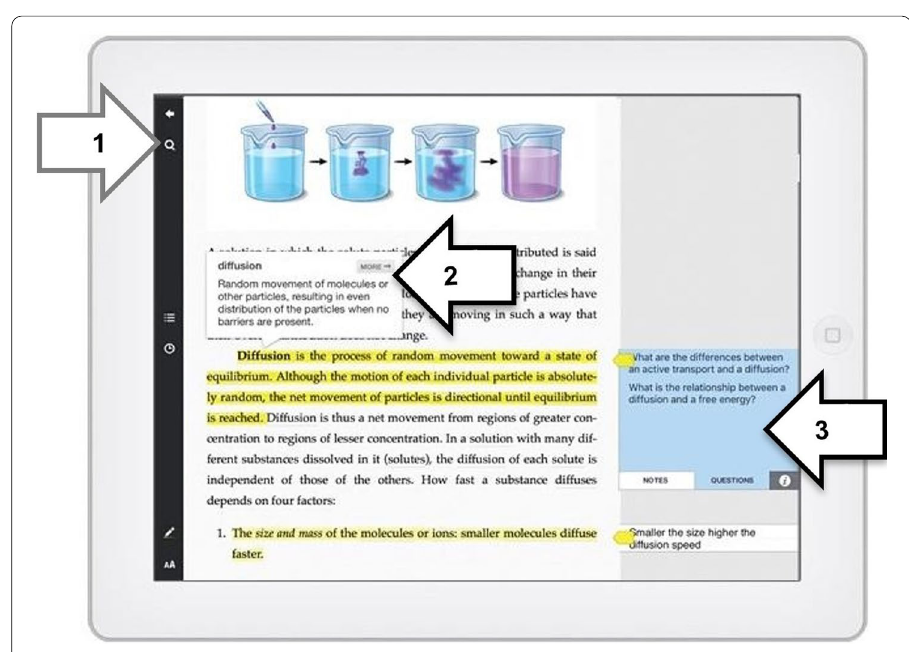
Fig. 2 Interface screenshot from the AI‑book showing opportunities to ask questions (1) or generate suggested questions (2, 3). Text and figures from LIFE (11th Edition) by David E. Sadava, David M. Hillis, H. Craig Heller and Sally D. Hacker. Copyright ©2017 by Macmillan Learning, Inc. Reprinted (used) by permission of Macmillan Learning, Inc